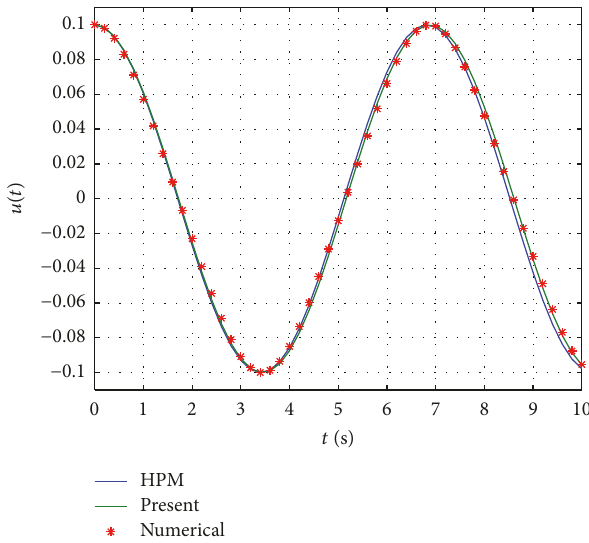
Figure 11: Comparison of time history diagram of displacement between the present, HPM, and numerical solutions at 𝛼 = 0, 𝛽 = 10, 𝐴 = 0.1 , Example 4.